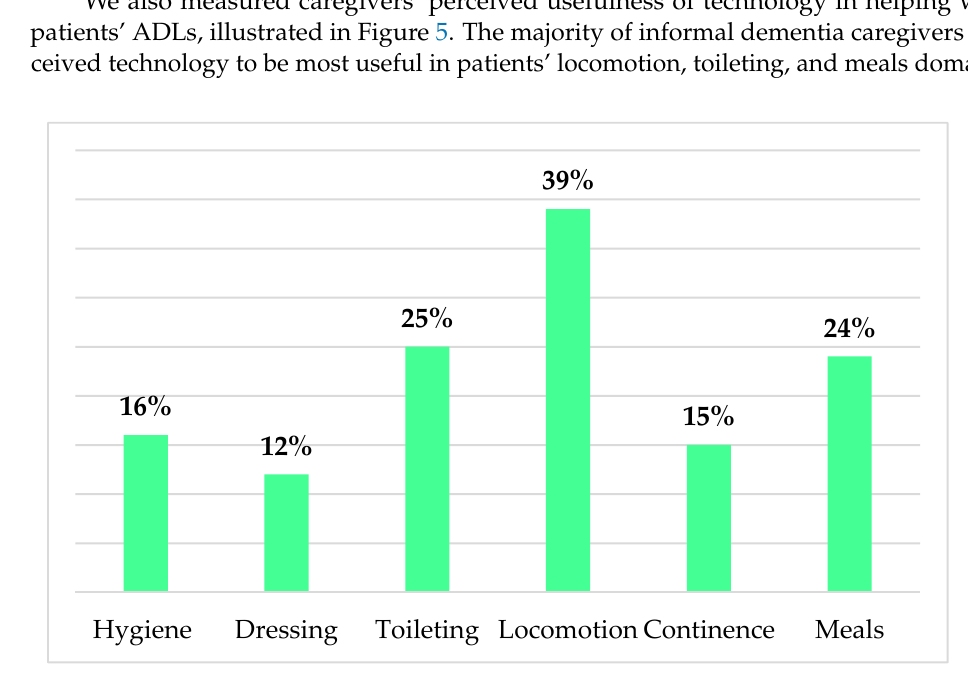
Figure 5. Usefulness of technology perceived by caregivers in helping with